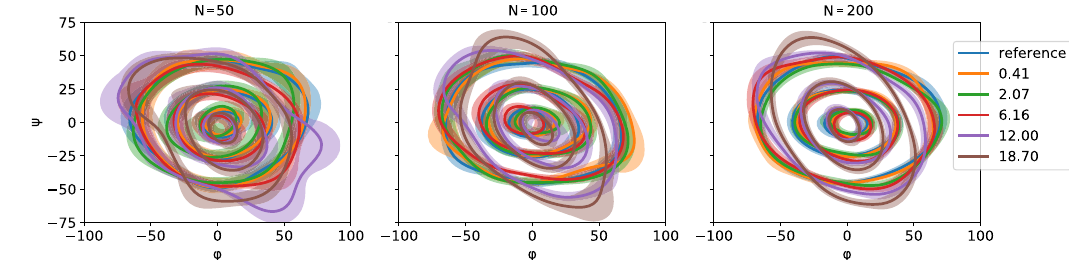
Fig. 8 Ramachandran plots of synthetic distributions from Fig. 6. Contours depict the level lines containing 10%, 50% and 90% of the probability mass. Shaded regions represent 10%-90% con fi dence intervals calculated on 1000 random bootstraps. The distributions are rotated one with respect to the other; the legend shows the ground truth Wasserstein (W 2 ) distance. Three sample sizes ( N = 50, 100, and 200) are shown left-to-right. Larger samples lead to narrower con fi